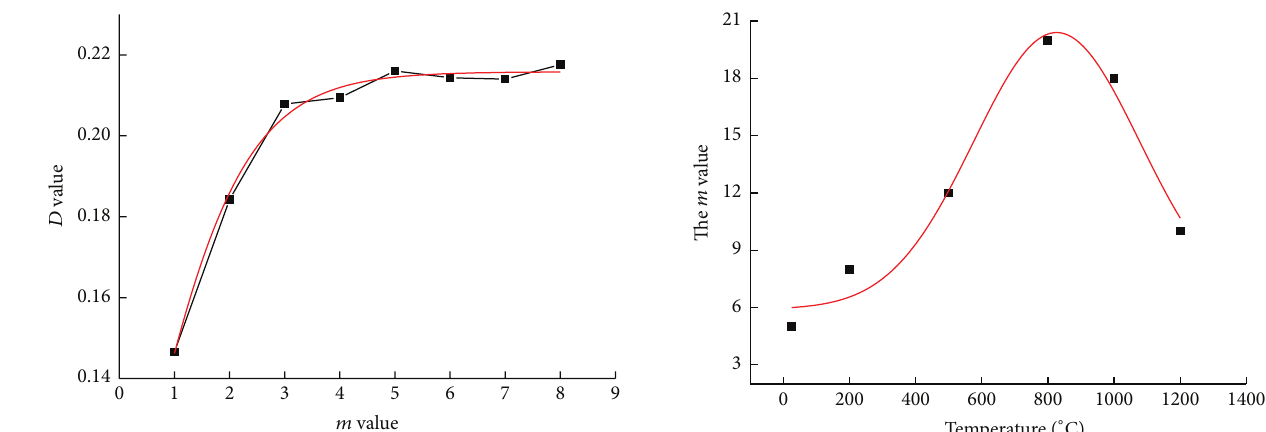
Figure 8: Variation of the 𝑚 value with increasing heat temperature.